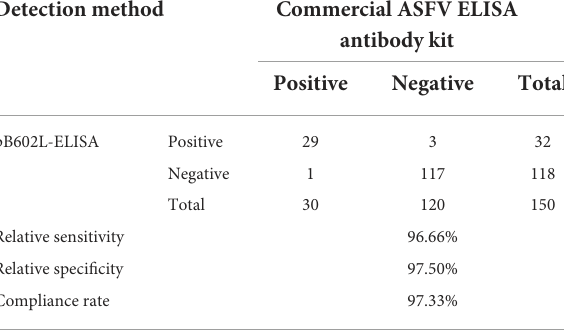
TABLE 4 Comparison of the pB602L-ELISA method and a commercial ELISA